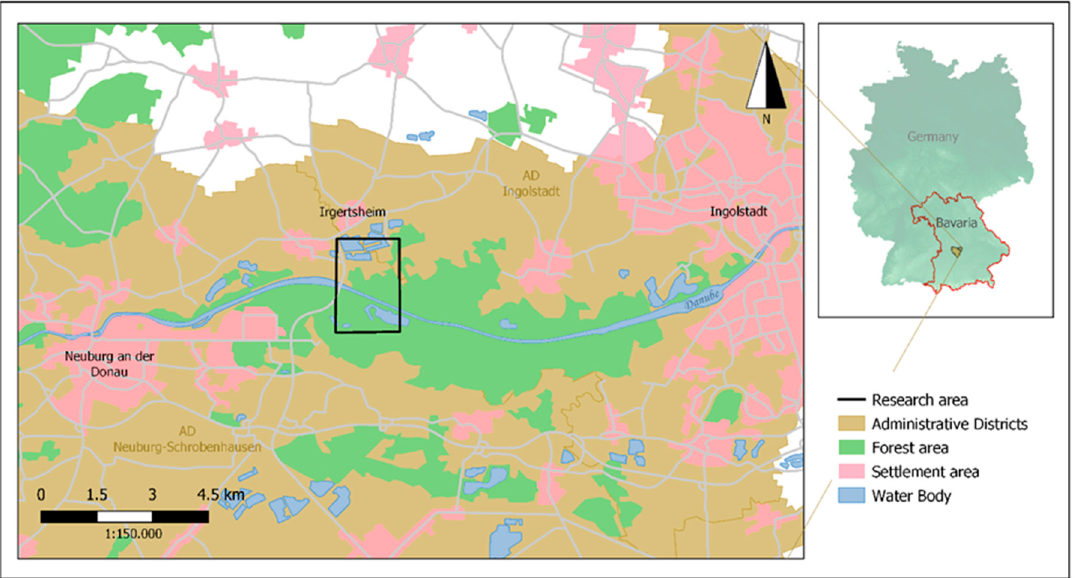
Figure 1. Localization of the study site (black rectangle) in Bavaria, Germany. (Basis data: Bundesamt für Kartographie und Geodäsie, Germany—DEM: 200 m, GK3; DLM: 250 m, GK3, 2019).